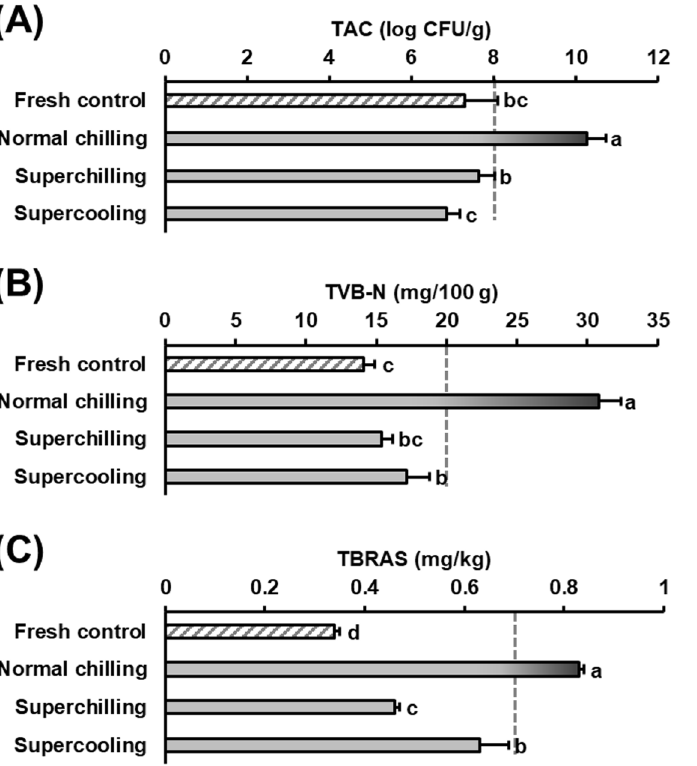
Figure 2. Comparisons of ( A ) total aerobic count (TAC), ( B ) total volatile basic nitrogen (TVB-N), and ( C ) thiobarbituric acid reactive substances (TBARS) of beef loins after 15 days of preservation. Bars indicate standard deviations ( n = 3).